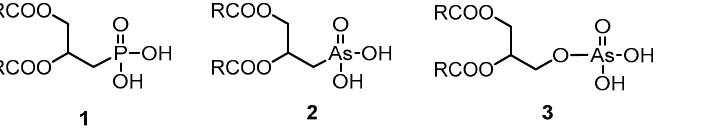
Figure 1. General structure of phosphonolipids 1 , arsonolipids 2 and O-As glycerol lipid analogs 3 .